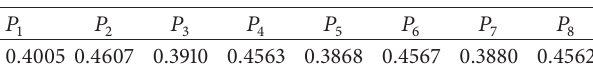
Table 5: Utility of strategic plans.